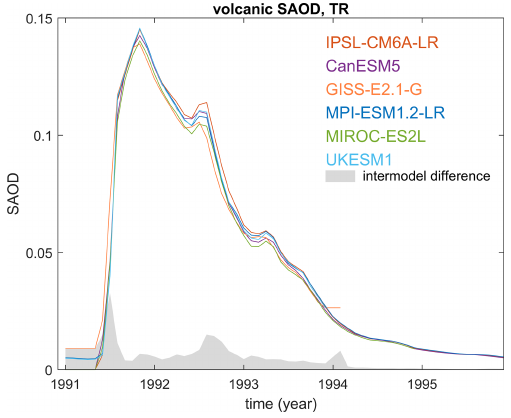
Figure 1. Monthly-mean aerosol optical depth at 550nm due to stratospheric volcanic aerosols (variable aod550volso4) averaged over the tropics (30 ◦ S–30 ◦ N) used in the volc-pinatubo-full ex-